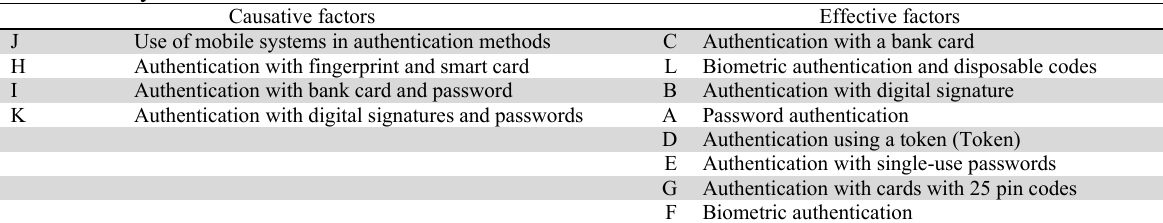
The summary of the cause and effect